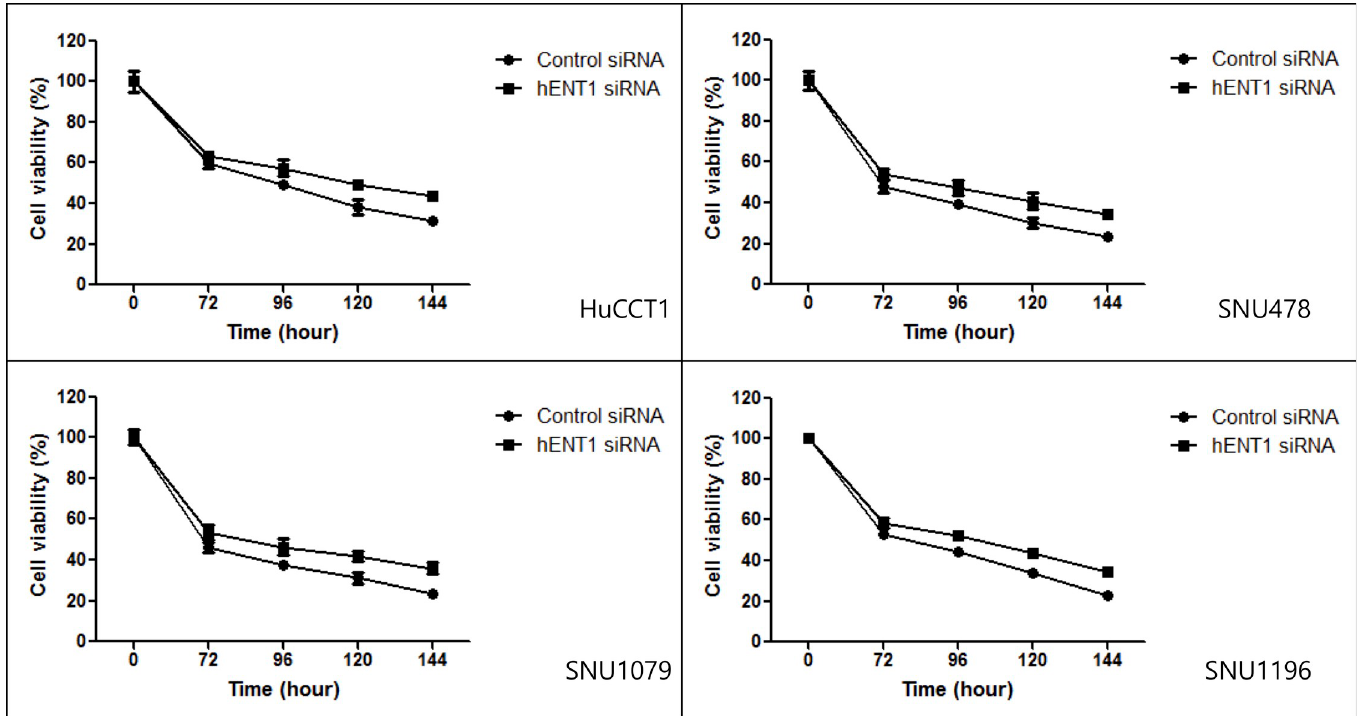
Fig 4. Effects of hENT1 siRNA on sensitivity of BTC cells to gemcitabine. Pretreatment with hENT1 siRNA was conducted to assess the effect of the hENT1 knockdown on gemcitabine sensitivity. During incubation with gemcitabine, in all cell lines, viability after hENT1 siRNA treatment was higher than that after control siRNA